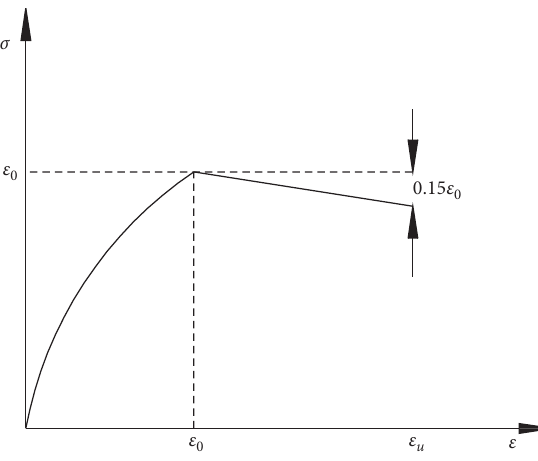
Figure 2: Stress-strain curve of